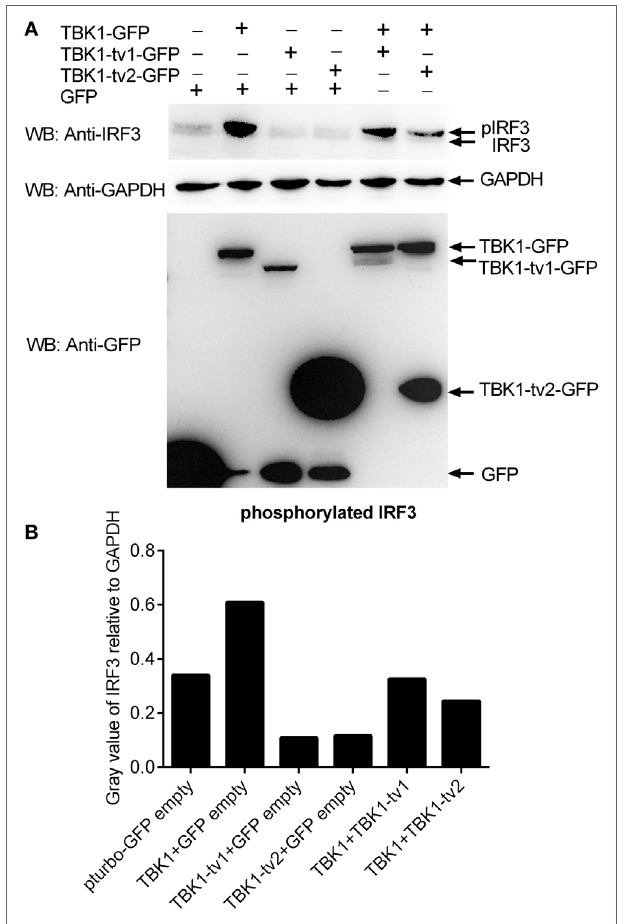
FigUre 6 | TANK-binding kinase 1 (TBK1) isoforms inhibit IRF3 phosphorylation mediated by TBK1. (a) Western blot analysis of the effect of TBK1 isoforms on IRF3 phosphorylation mediated by TBK1. (B) Densitometric analysis of the effect of TBK1 isoforms on IRF3 phosphorylation mediated by TBK1. For Western blot analysis, epithelioma papulosum cyprini cells were plated in six-well plates, incubated overnight, and subsequently transfected with 1.5 µg of each of the plasmids. After 36 h, cells were collected and used for protein extraction. Cell lysates were immunoblotted using anti-IRF3 antibody (1:5,000, upper panels), anti-GAPDH antibody (1:2,000, middle panels), and anti-GFP antibody (1:5,000, lower panels). The levels of phosphorylated IRF3 were quantified by measuring the band densitometry using Quantity One software (BioRad), which are normalized to band densitometry of GAPDH. Each Western blot is representative of at least two independent